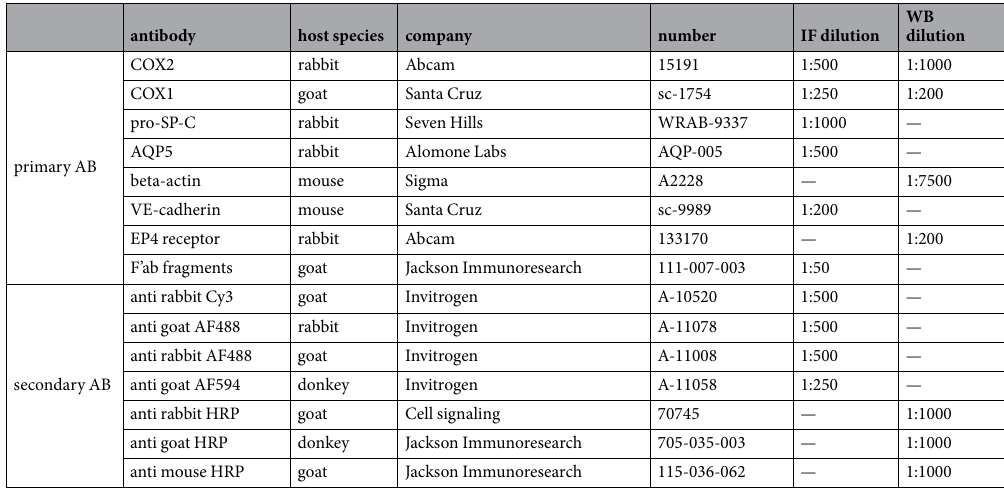
Table 1. Antibodies (AB) used in Western blots (WB) and immunofluorescence (IF)